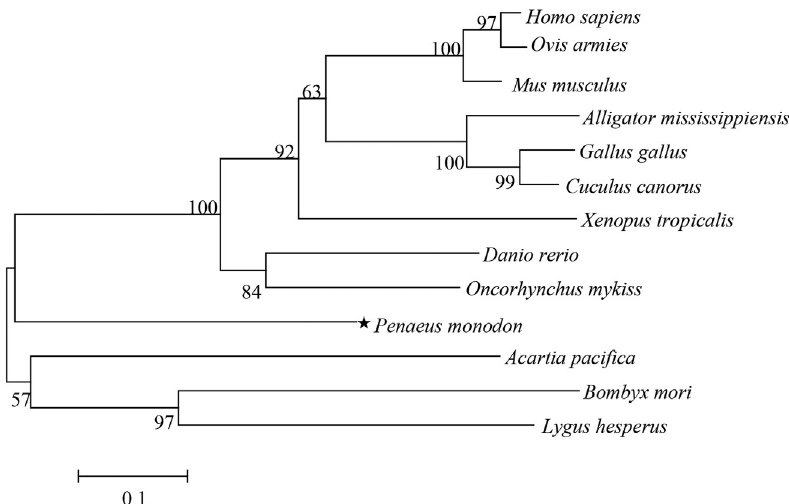
Figure 3 - NJ phylogenetic tree based on amino acid sequence encoded by PDRG1 as revealed by MEGA 5. 0 software. The numbers above the branches represent bootstrap values (1000 replicates). The following PDRG1 proteins family members were used in the phylogenetic analysis: Homo sapiens (NP_110442.1); Ovis aries (XP_004014522.1); Mus musculus (NP_849270.1); Alligator mississippiensis (KYO24169.1); Gallus gallus (XP_015151961.1); Cuculus canorus (XP_009560934.1); Xenopus tropicalis (NP_001015688.1); Danio rerio (NP_001017757.1); Oncorhynchus